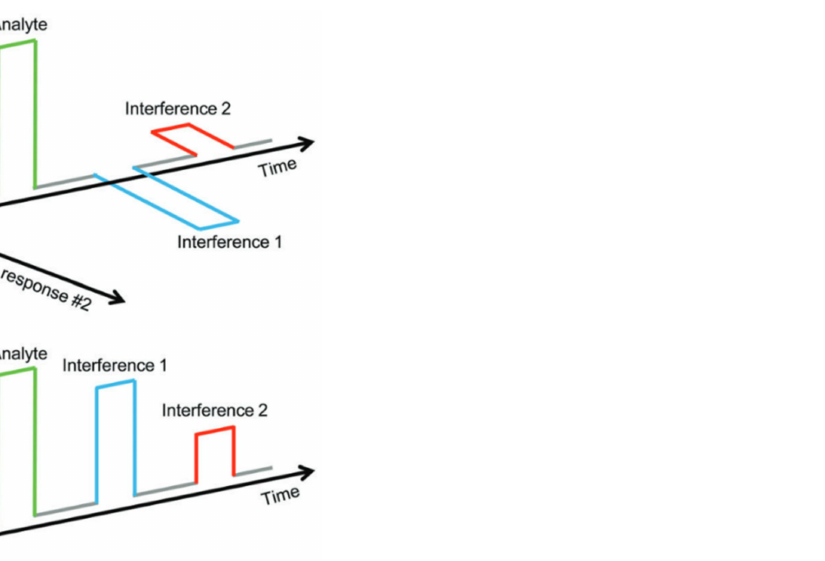
Figure 8. Illustration of the advantages of multivariate sensor systems. Analyte and interference responses are well distinguishable. Picture from [160].